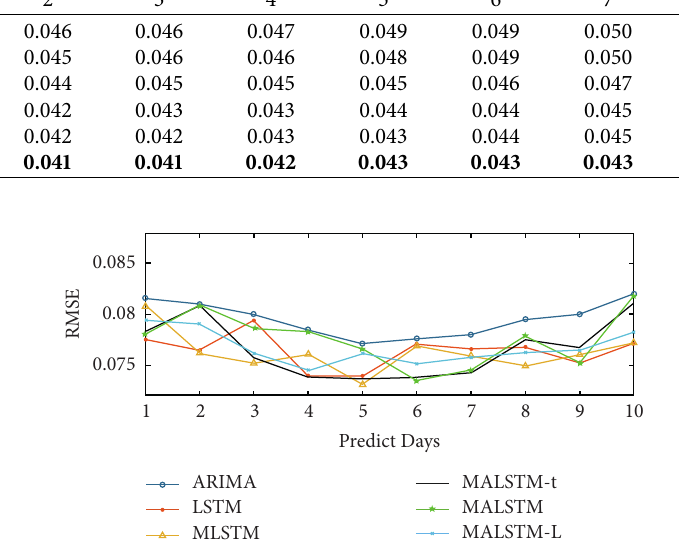
Figure 4: Experimental results of RMSE.